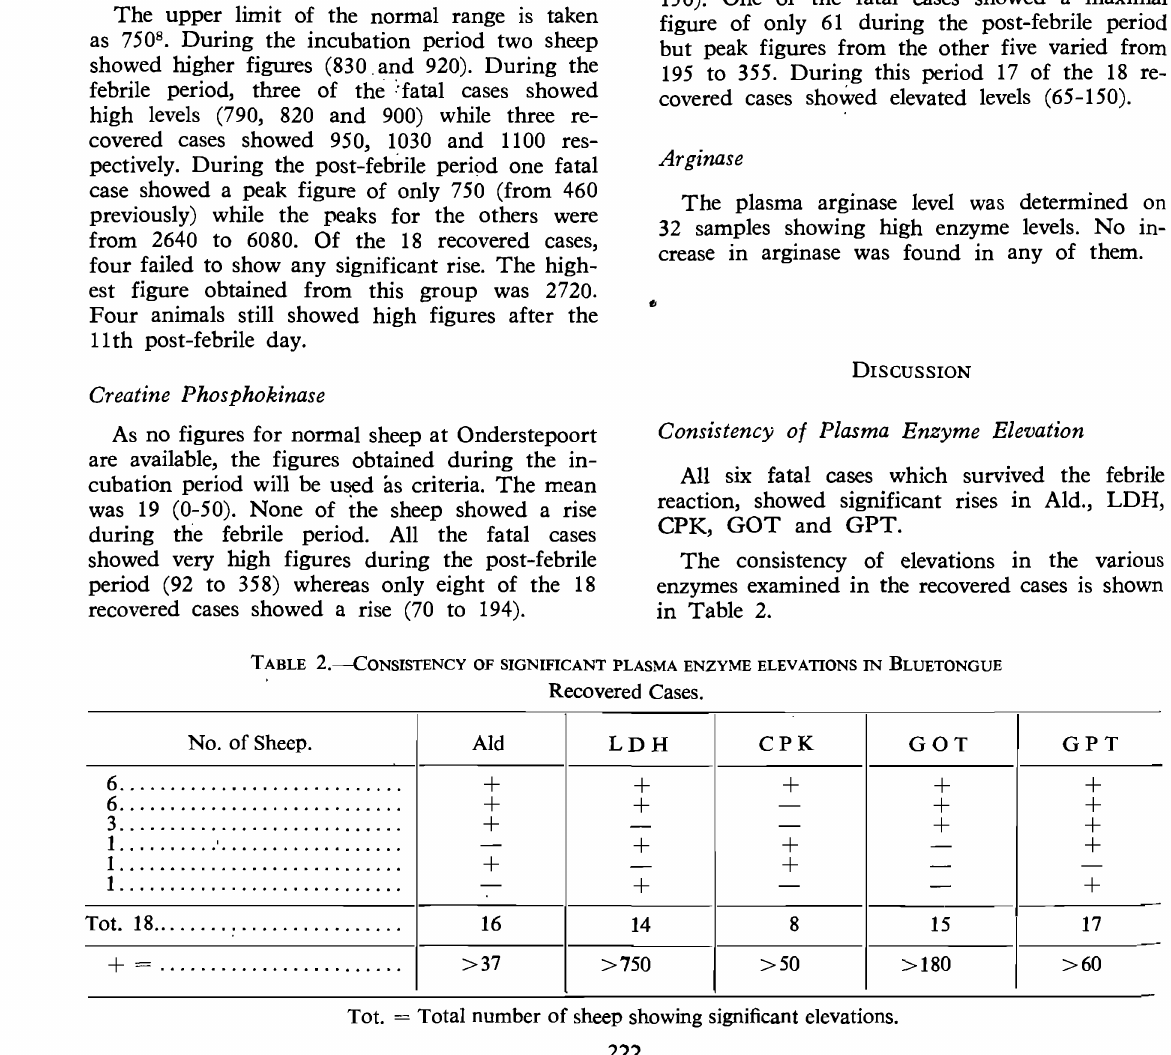
TABLE 2.--CONSISTENCY OF SIGNIFICANT PLASMA ENZYME ELEVATIONS IN BLUETONGUE Recovered